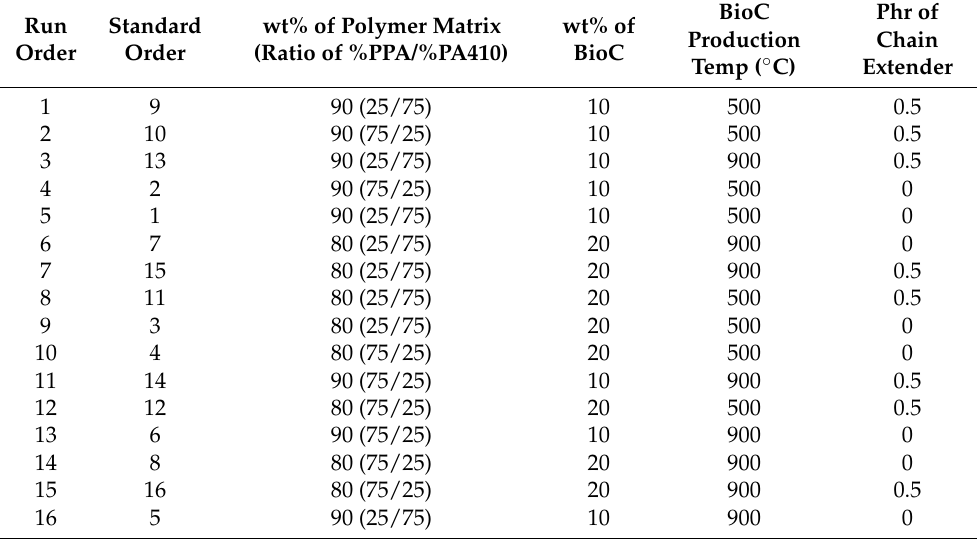
Table 4. Coding and running order of the processing of the